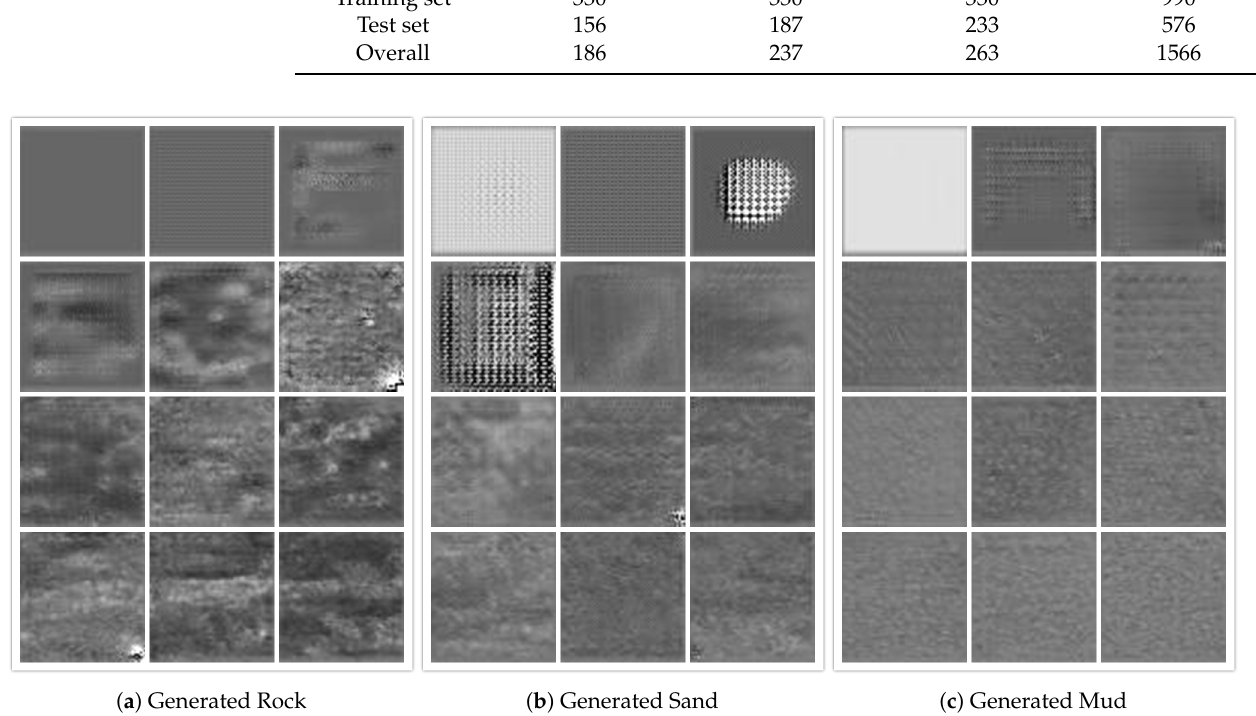
Figure 7. From left to right, from top to bottom, the different types of seabed sediment images generated by SAGAN are shown in turn with the increasing number of epochs. As the epochs increases, the three types of seabed sediment images generated by SAGAN gradually change from fuzzy and abstract to clear and